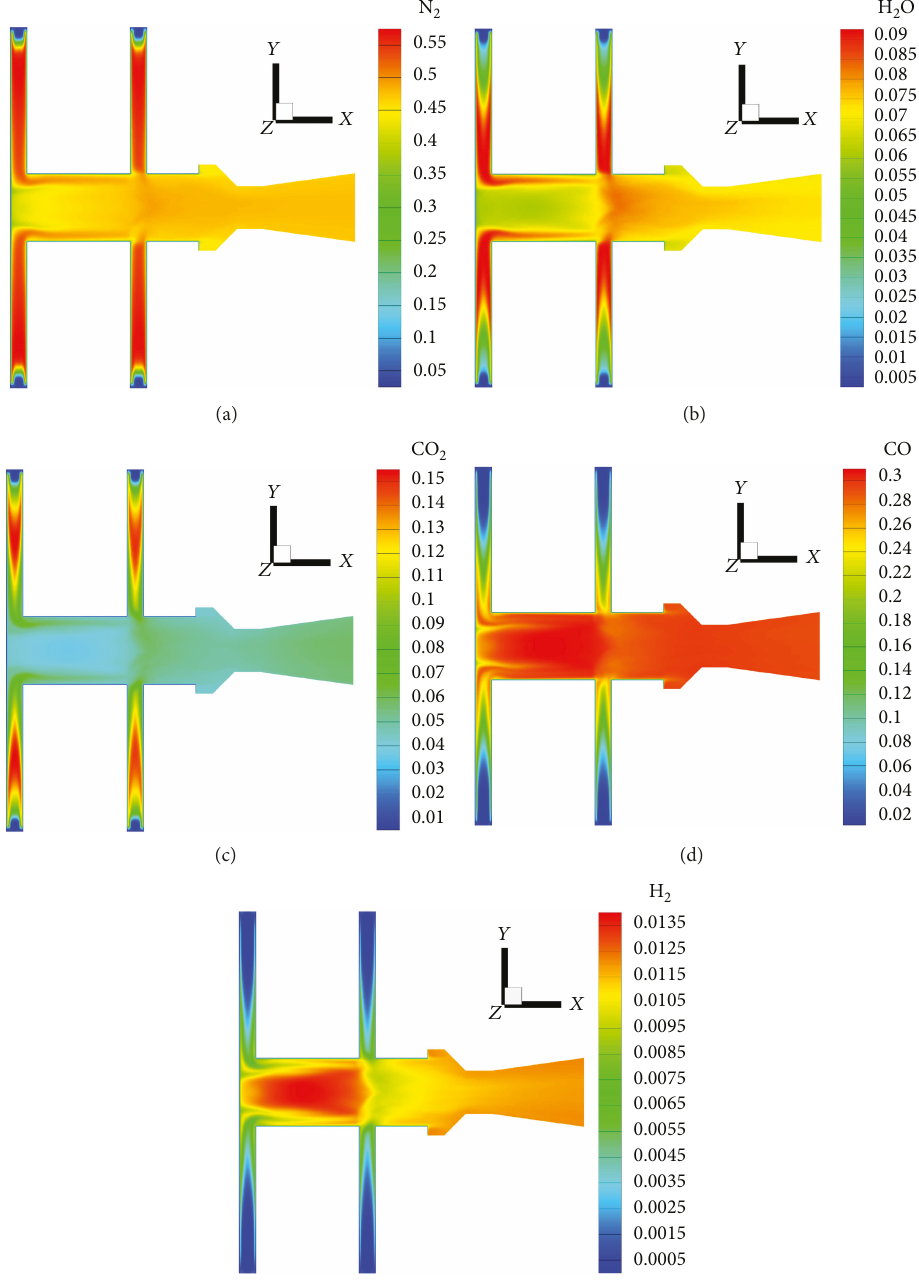
Figure 10: Mass fraction of major products: (a) N